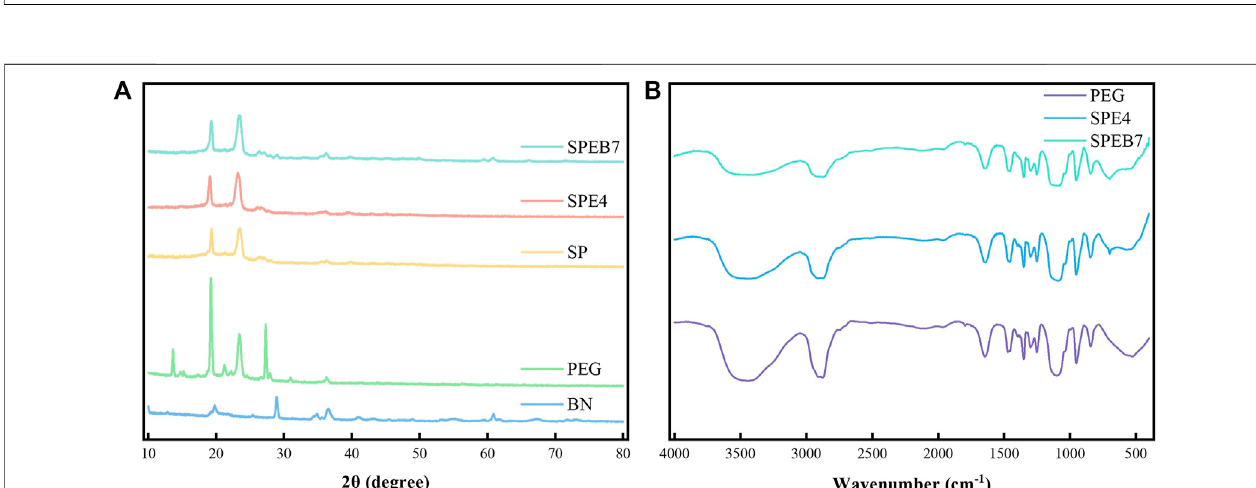
FIGURE 3 | (A) XRD curves of the different samples. (B) Fourier transform infrared spectroscopy (FT-IR) spectra of the different samples.